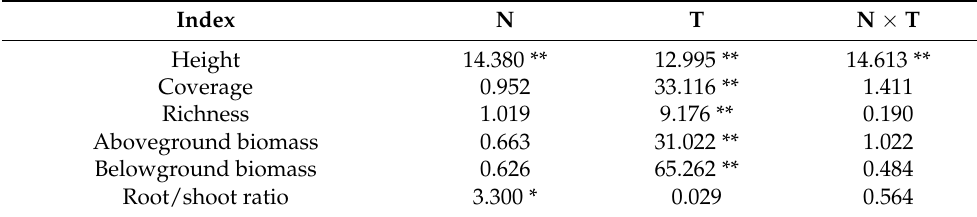
Table 1. Effects of nutrient addition and time on F-values from ANOVA on population characteristics of P. kansuensis